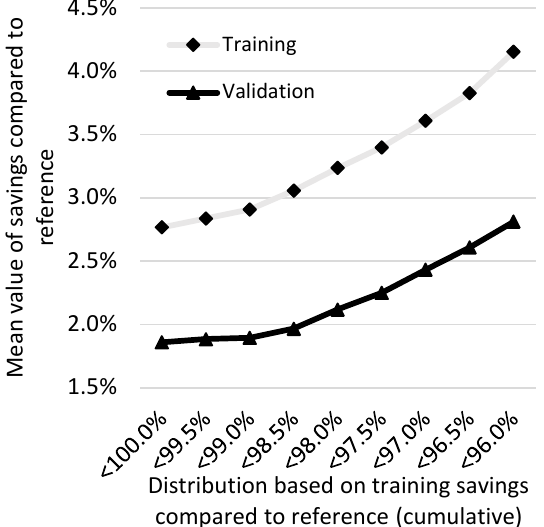
Figure 9. Average savings of trained agents on the validation dataset.